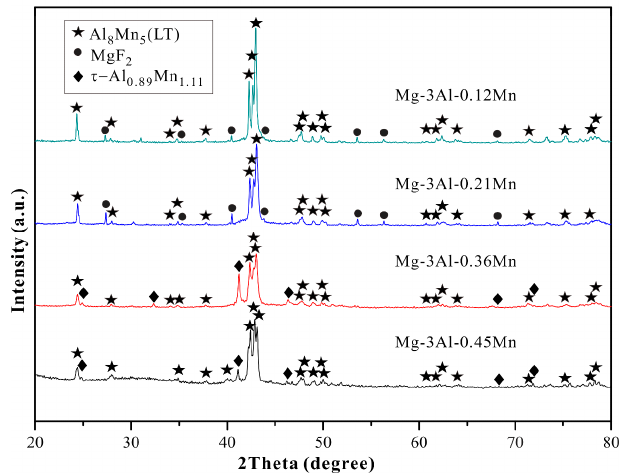
Figure 8. XRD patterns of the extracted particles in the Mg-3Al- x Mn alloys ( x = 0.12, 0.21, 0.36, 0.45). Note that the particles in the Mg-3Al alloy were not extracted successfully due to the limited amount.